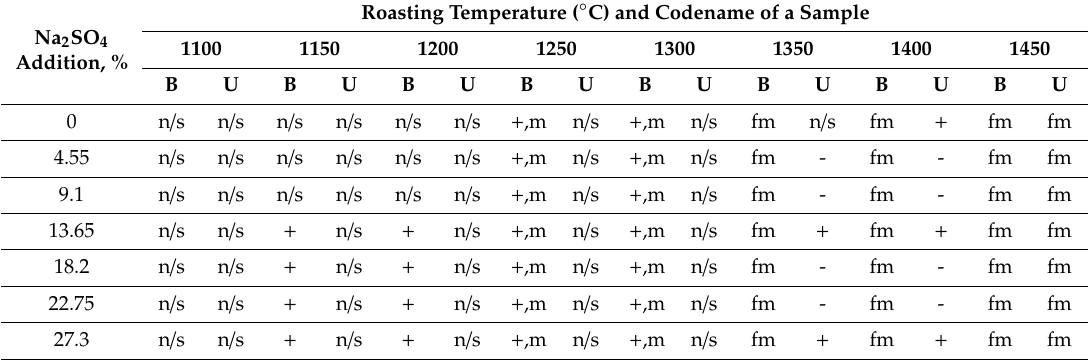
Table 4. General results with signs * of the roasting and magnetic separation of the samples B and U roasted at various temperatures and Na 2 SO 4 addition during 180